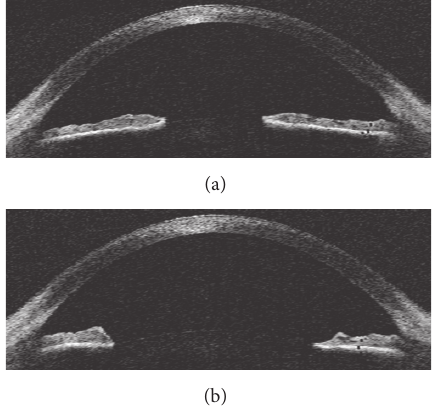
Figure 2: Anterior segment image of the human eye taken by Optical Coherence Tomography by means of the Visante Omni System (Carl Zeiss AG, Oberkochen, Germany). (a) Under myosis conditions (constriction of the pupil). (b) Under mydriatic condi- tions (dilation of the